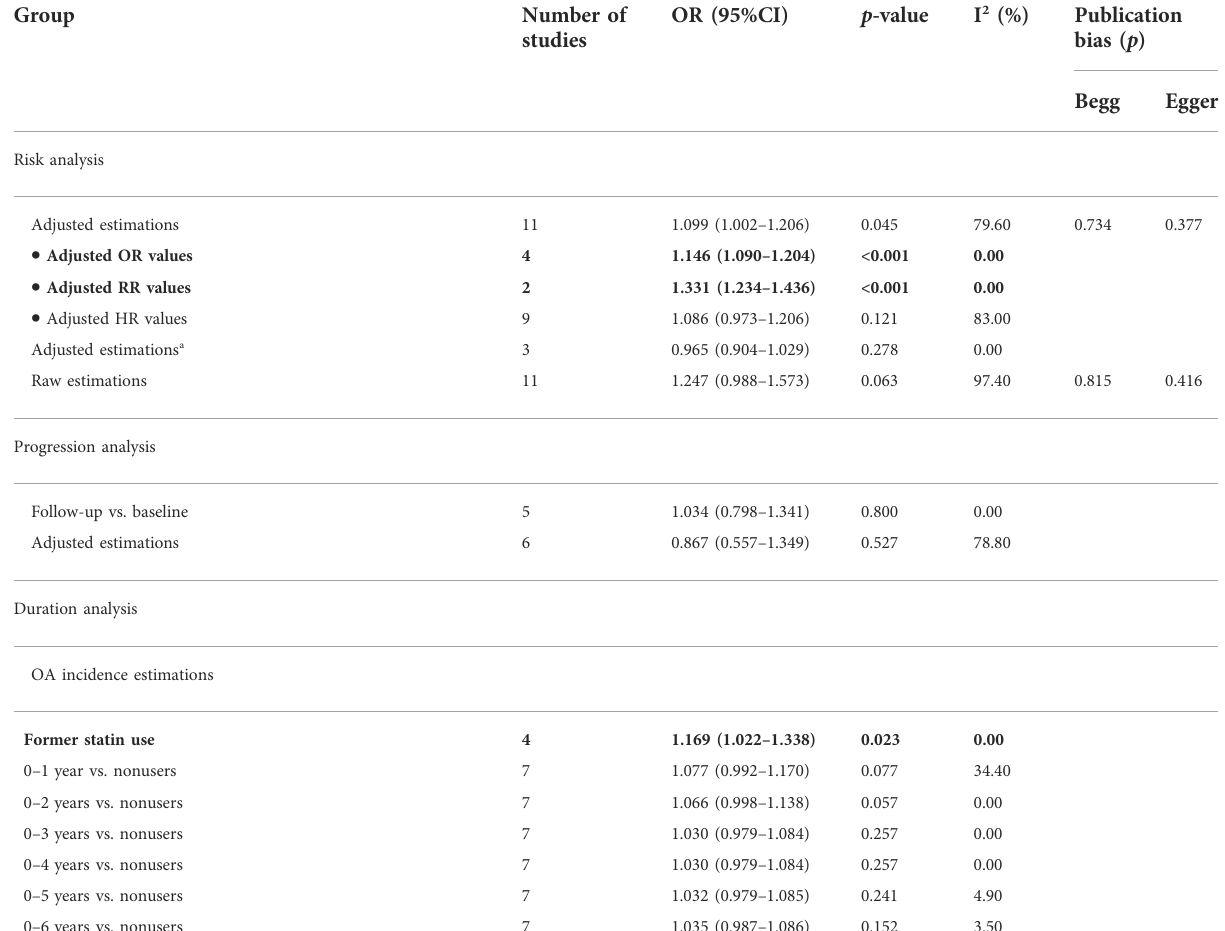
TABLE 2 Results of Meta-analysis of the correlations between statin use and OA-related